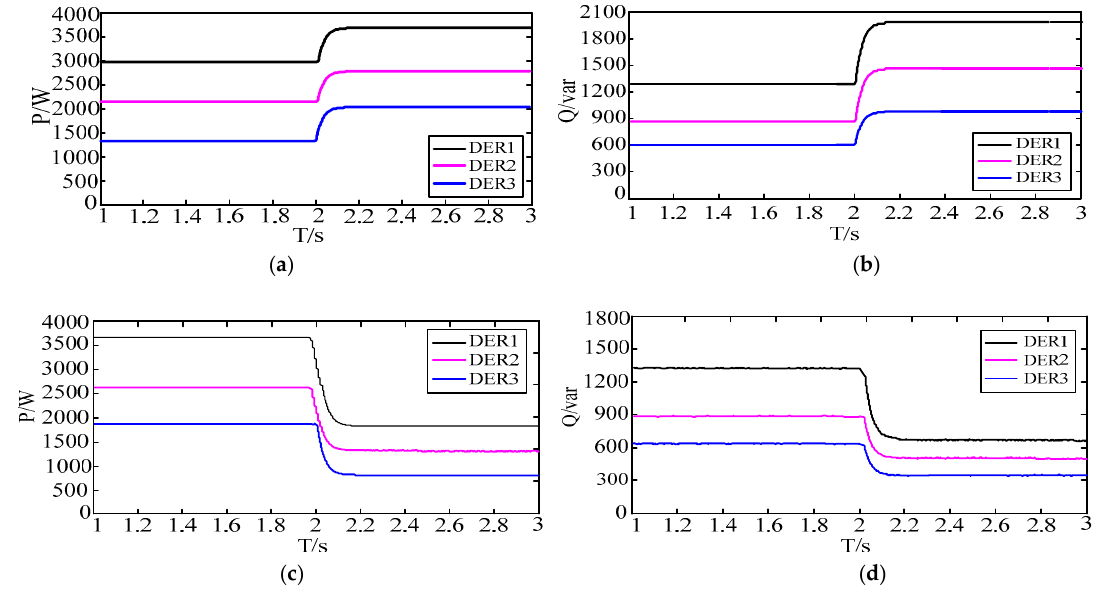
Figure 10. Variations of output power of DERs when Load disturbance occurs in the system. ( a ) The output active power of DERs with increasing Load2; ( b ) The output reactive power of DERs with increasing Load2; ( c )The output active power of DERs with decreasing Load2; ( d ) The output reactive power of DERs with decreasing Load2.